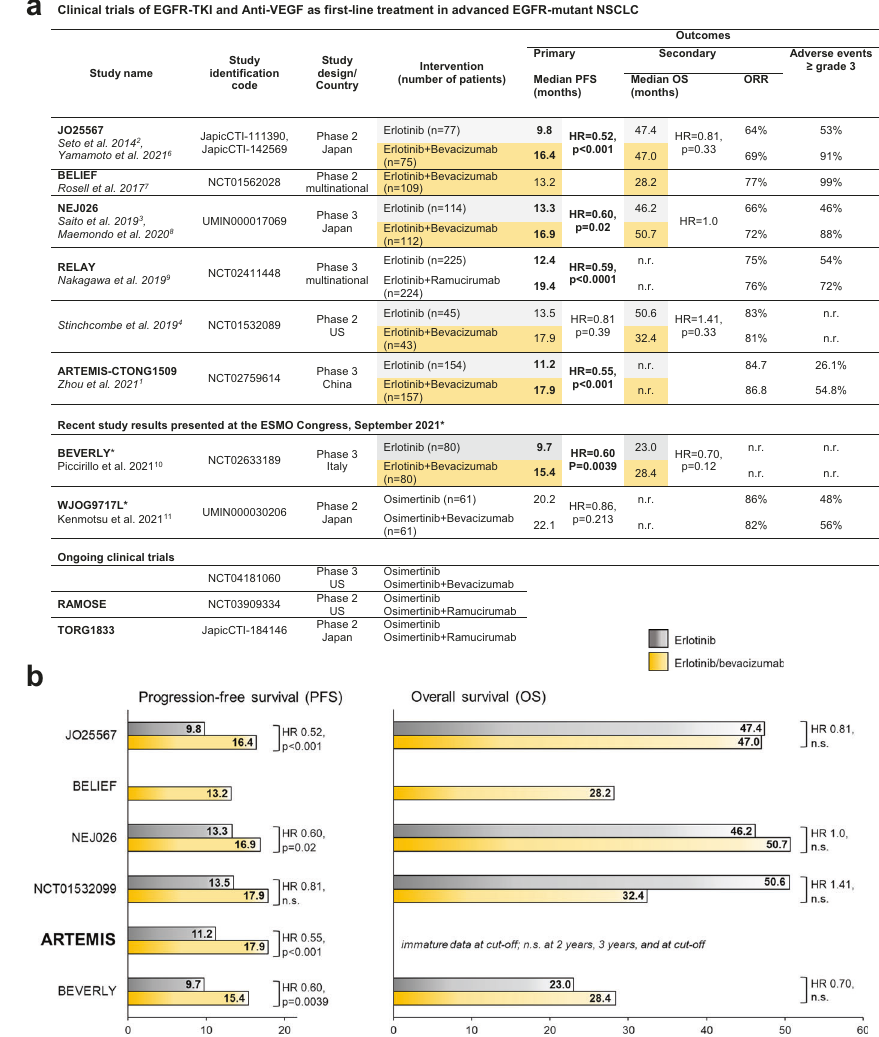
Fig. 1 Clinical trials of EGFR-TKI and Anti-VEGF as fi rst-line treatment in advanced EGFR-mutant NSCLC. a Overview on the completed and ongoing clinical trials of EGFR-TKI and Anti-VEGF as fi rst-line treatment in advanced EGFR-mutant NSCLC. Modi fi ed and updated from: Chen et al. 2020 5 ; data were extracted from the indexed publications and/or publically available clinical trial databases; bold values indicate signi fi cant differences; grey and yellow colors highlight study data for PFS and OS with erlotinib and erlotinib + bevacizumab treatment, which are illustrated in ( b ). *Data presented at the European Society for Medical Oncology (ESMO) Conference, September 2021; PFS refers to investigator-assessed PFS in the BEVERLY trial and blinded independent radiologic reviewer-assessed PFS in the WJOG8717L trial, respectively. EGFR epidermal growth factor receptor, PFS progression-free survival, ORR objective response rate, OS overall survival, n.r. not reported, TKI tyrosine kinase inhibitor 6 – 11 . b Progression-free survival (left panel) and overall survival (right panel) in prospective phase 2 and 3 clinical trials of EGFR-TKI erlotinib and bevacizumab as fi rst-line treatment in advanced EGFR-mutant